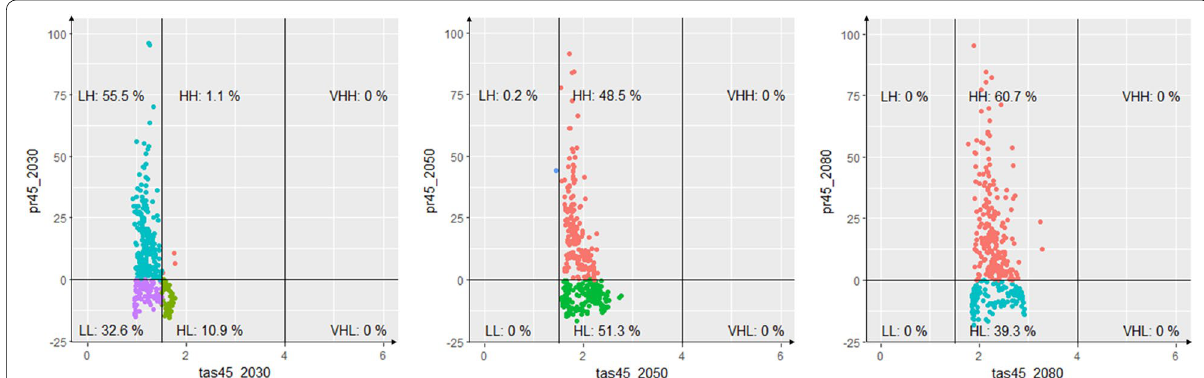
Fig. 2 Combined variability of temperature in DegC (X-axis) and rainfall in mm/day (Y-axis) under RCP 4.5 (left to right: 2030, 2050, 2080). LH: Low temperature High precipitation, HH: High temperature High precipitation, VHH: Very High temperature High precipitation, LL: Low temperature Low precipitation, HL: High temperature Low precipitation, VHL: Very High temperature Low